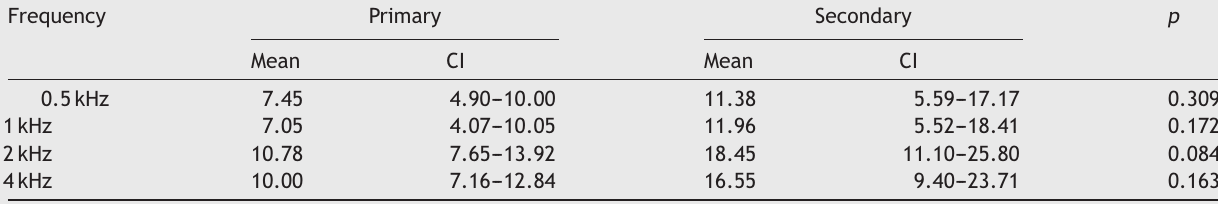
Mean bone threshold (in dB) at different frequencies (in kHz) according to the type of cholesteatoma. Frequency Primary